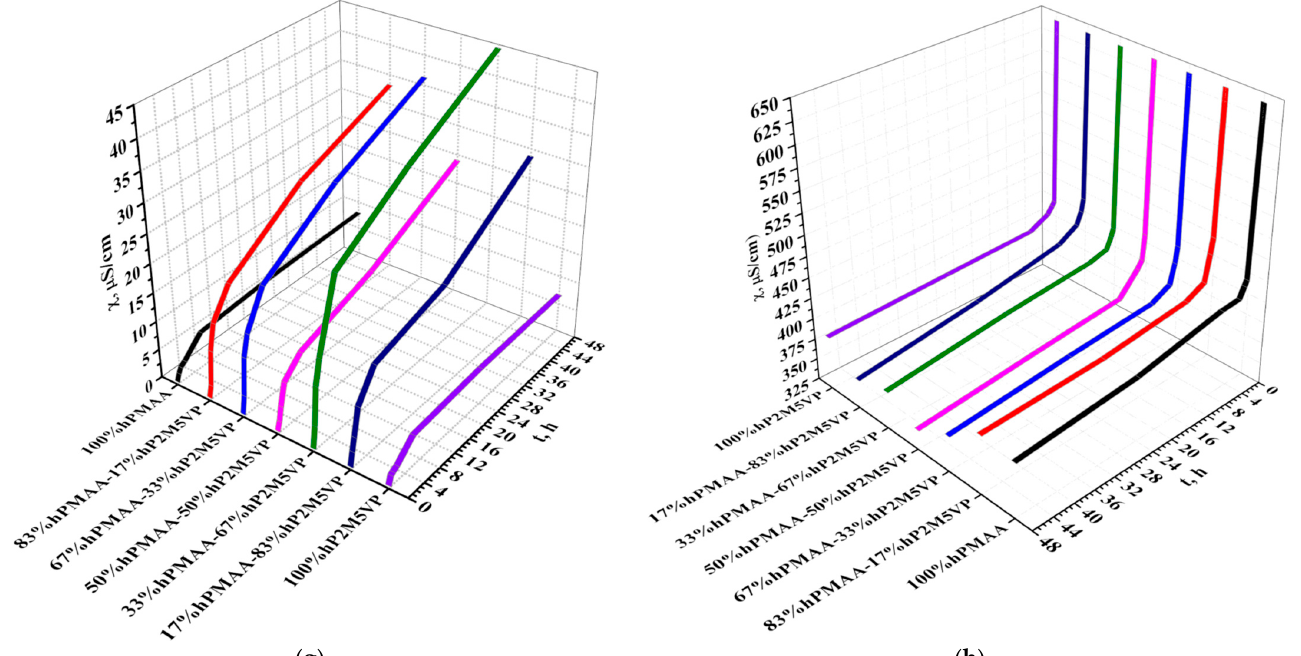
Figure 1. Electric conductivity of water ( a , c , e , g ) and lanthanum nitrate ( b , d , f , h ) in presence of interpolymer systems.